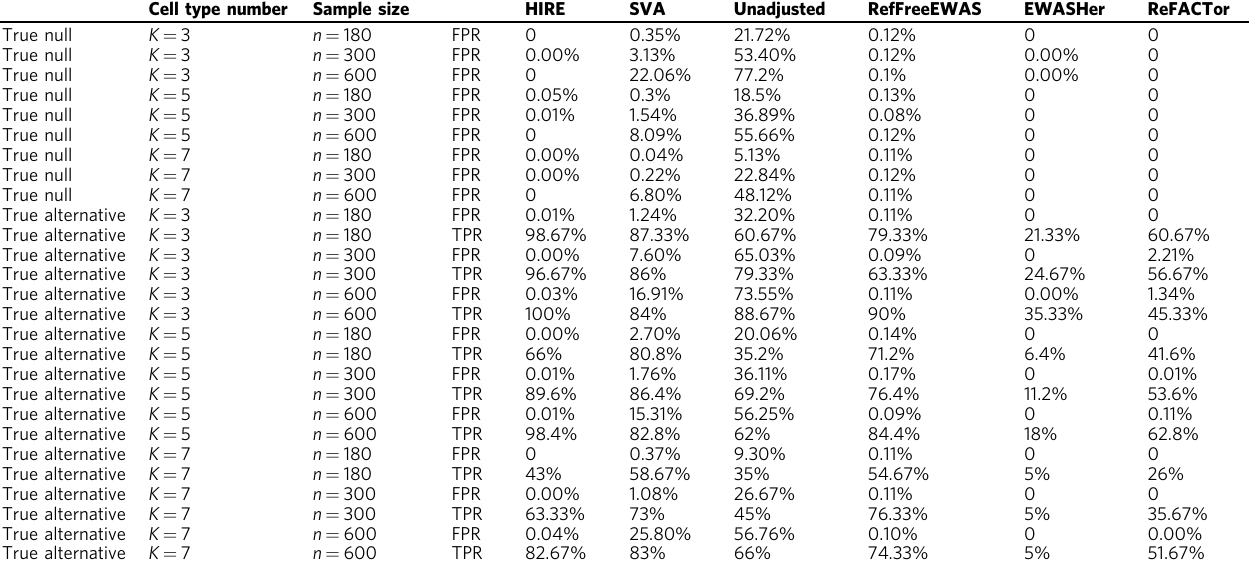
Table 1 Performance of HIRE and other competing methods in simulation studies Cell type number Sample